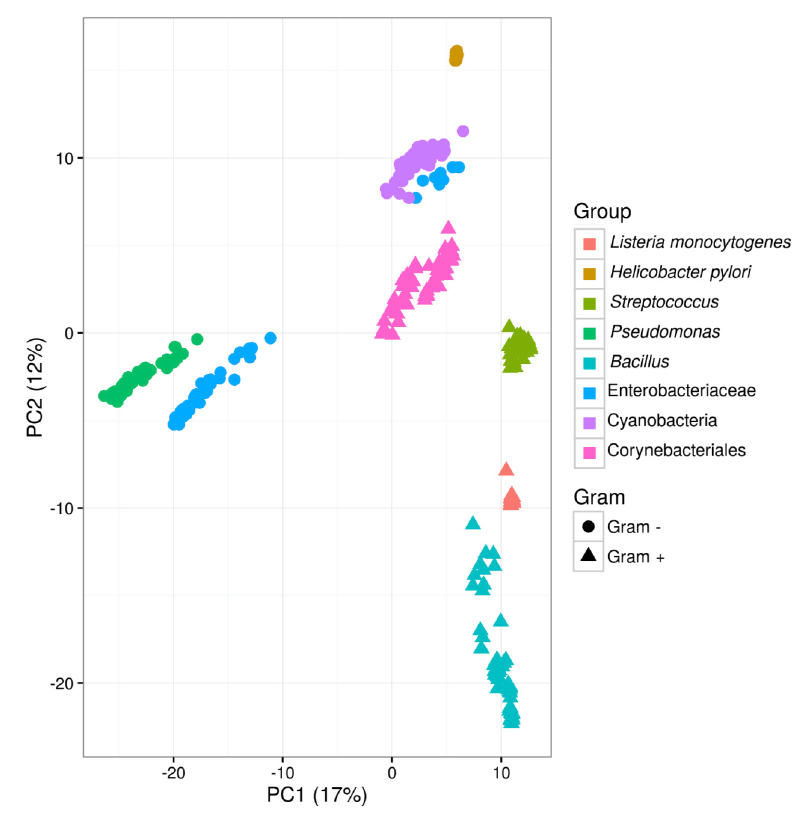
Figure 7. Large scale functional comparison of species. Principal component analysis of functional similarities of 446 genomes based on the presence/absence of domain architectures on the corresponding genomes. The variance explained by the first two components is indicated on axes labels.